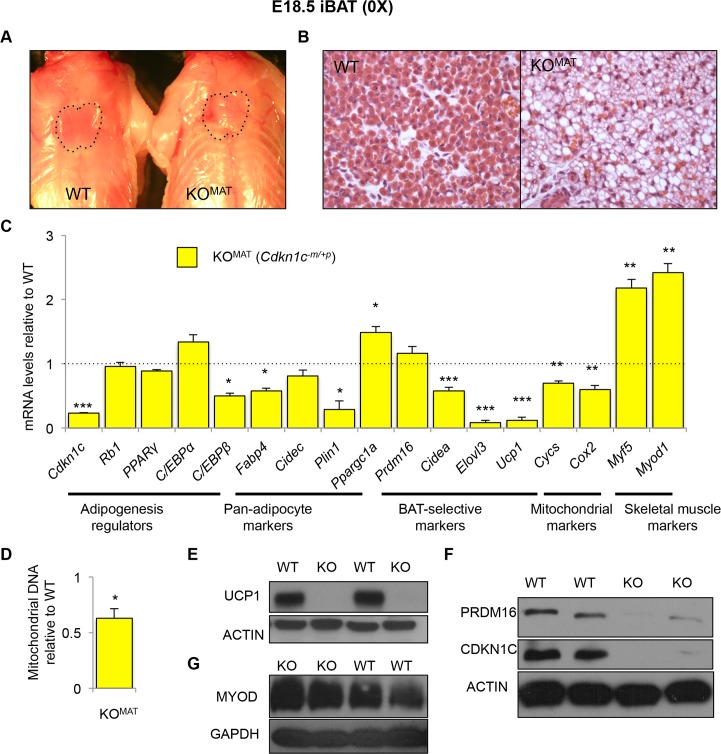
Cdkn1c is required for the proper formation of iBAT.(A) Photograph of E18.5 WT and Cdkn1c-/+ (KOMAT) fetuses with position of iBAT depot highlighted by dotted black line. (B) H&E staining of iBAT sections of E18.5 WT and KOMAT iBAT. (C) QPCR of Cdkn1c and the adipocyte regulators Rb1, PPARγ, C/EBPα and C/EBPβ, pan-adipocyte genes Fabp4, Cidec and Plin1, BAT-selective genes Ppargc1a, Cidea, Prdm16, Ucp1 and Elovl3, mitochondrial genes Cycs and Cox2, and the skeletal muscle-selective genes Myf5 and Myod1 in E18.5 KOMAT iBAT relative to WT (n = 4 per genotype). (D) Mitochondrial DNA content of iBAT from E18.5 KOMAT iBAT relative to WT (n = 6 per genotype). (E) Western blot analysis of UCP1 and β-ACTIN in E18.5 iBAT isolated from two WT and two KOMAT fetuses. Within litter comparison. (F) Western blot analysis of CDKN1C, PRDM16 and β-ACTIN in E18.5 iBAT isolated from two WT and two KOMAT fetuses. Within litter comparison. (G) Western blot analysis of MYOD and GAPDH in E18.5 iBAT isolated from two WT and two KOMAT fetuses. Within litter comparison. Data expressed as mean ± SEM, t test. * P <0.05; ** P <0.01; *** P <0.005.